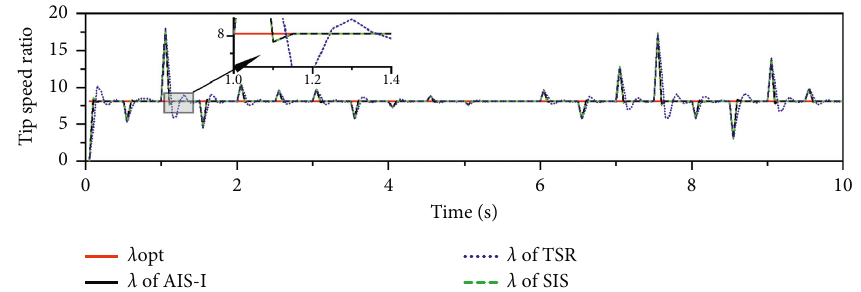
Figure 10: Tip speed ratio based on AIS-I, TSR, and SIS